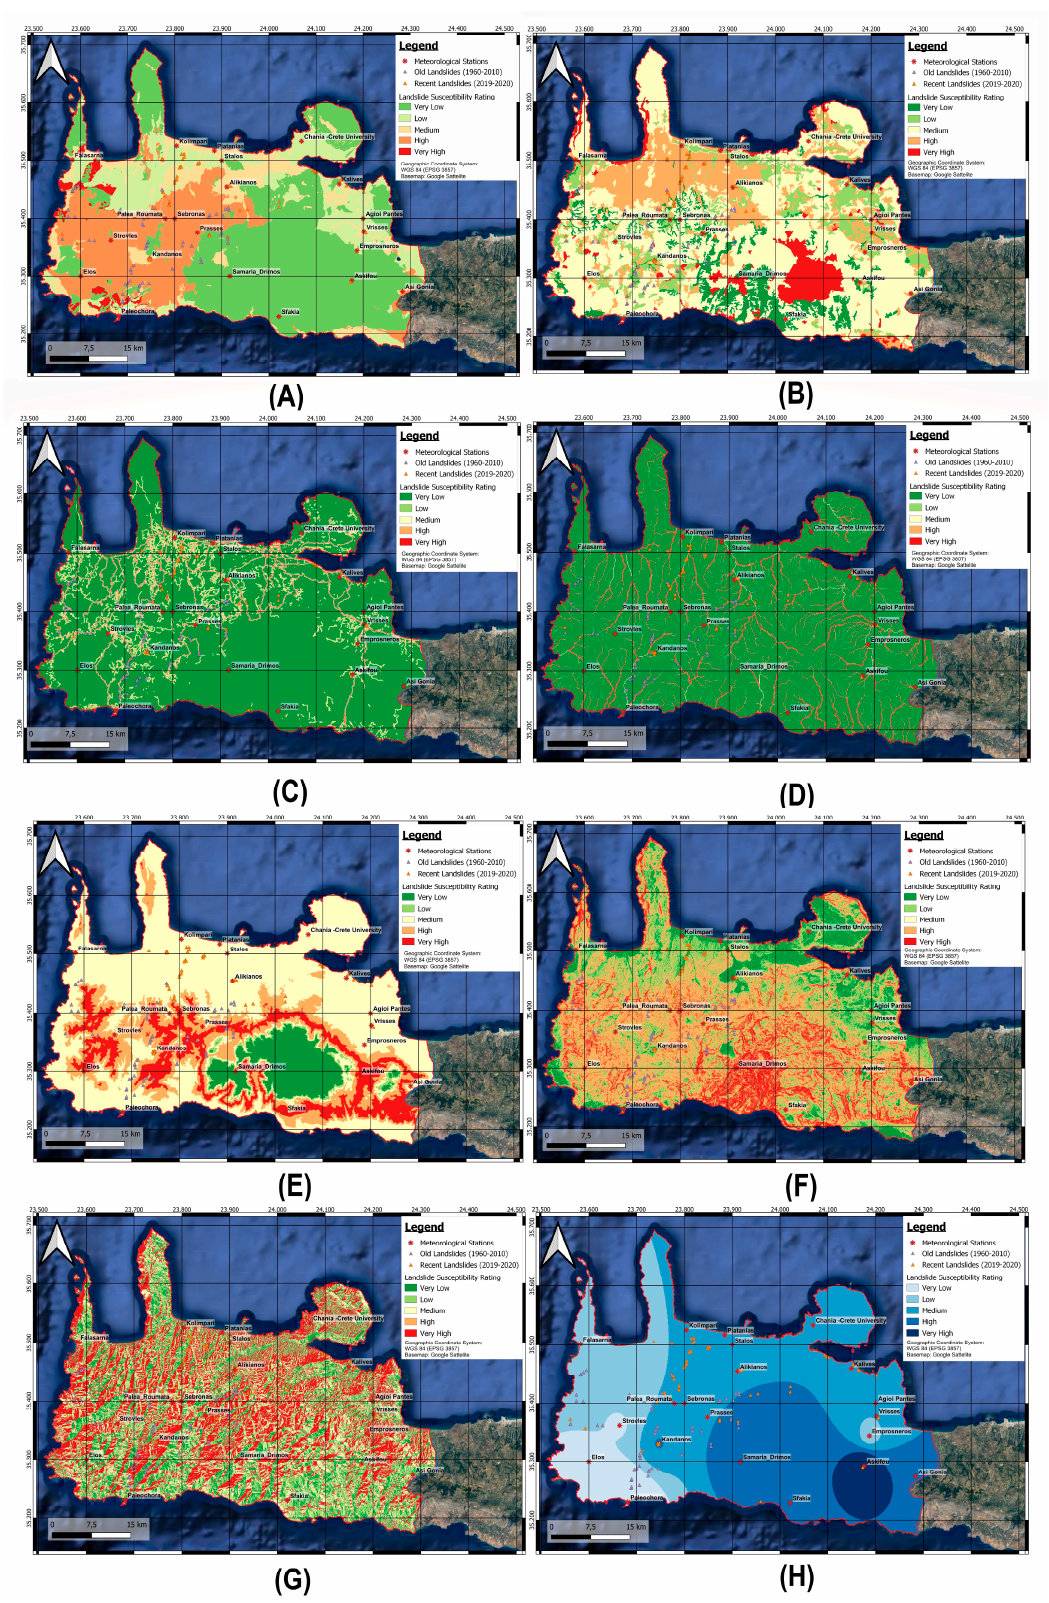
Figure 14. LS Maps for individual causal factors for landslides in the Chania regional unit, Greece: ( A ) lithology, ( B ) land use/land cover, ( C ) proximity of roads, ( D ) proximity of streams, ( E ) the relative relief, ( F ) slope angle, ( G ) slope aspect, and ( H ) mean annual precipitation for the preceding 10 years (MAP-10).